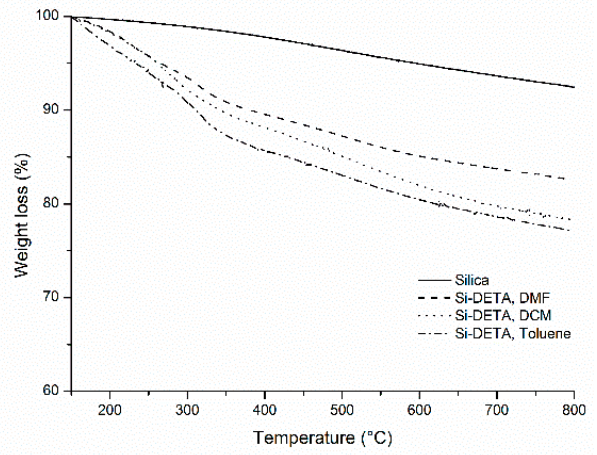
Figure 2. TGA profiles of starting silica and Si-DETA substrates (Table 1, Entries 1–3). The reaction mixture was heated at 60 °C and conventionally stirred for 12 h. Three different solvents were tested. Solid line, starting silica; dashed line, Si-DETA prepared in DMF, Table 1, Entry 2; dotted line, Si- DETA prepared in DCM, Table 1, Entry 1; dashed-dotted line, Si-DETA prepared in toluene, Table 1, Entry 3.